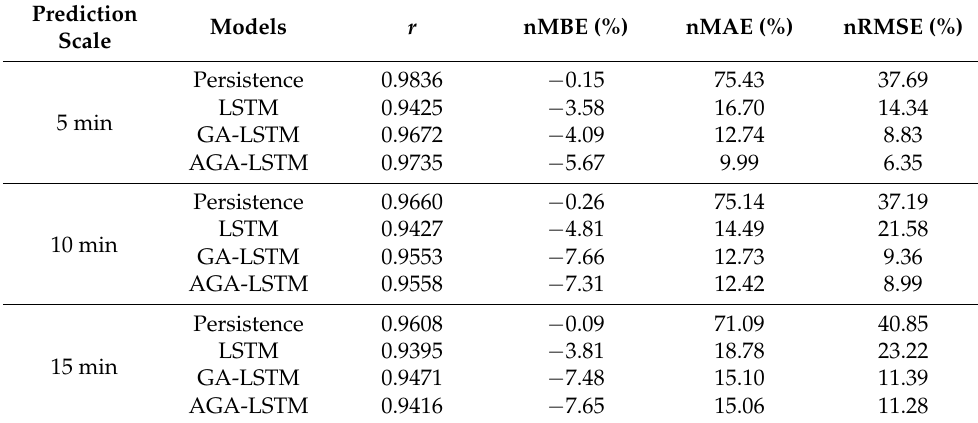
Table 2. The performance of AGA-LSTM models for predicting GHI.